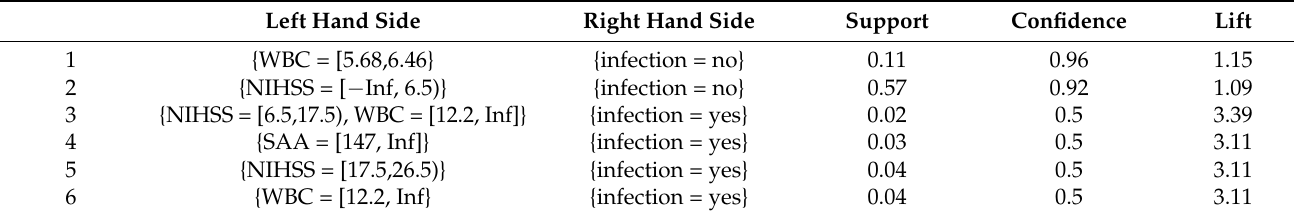
Table 5. Classification and association rules in the validation subgroup.